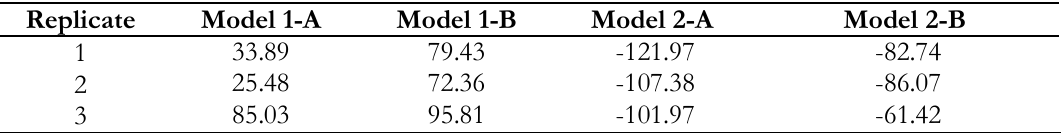
Table I. AICc Parameters of model 1-A, 1-B, 2-A and 2-B to describe transdermal transport of losartan